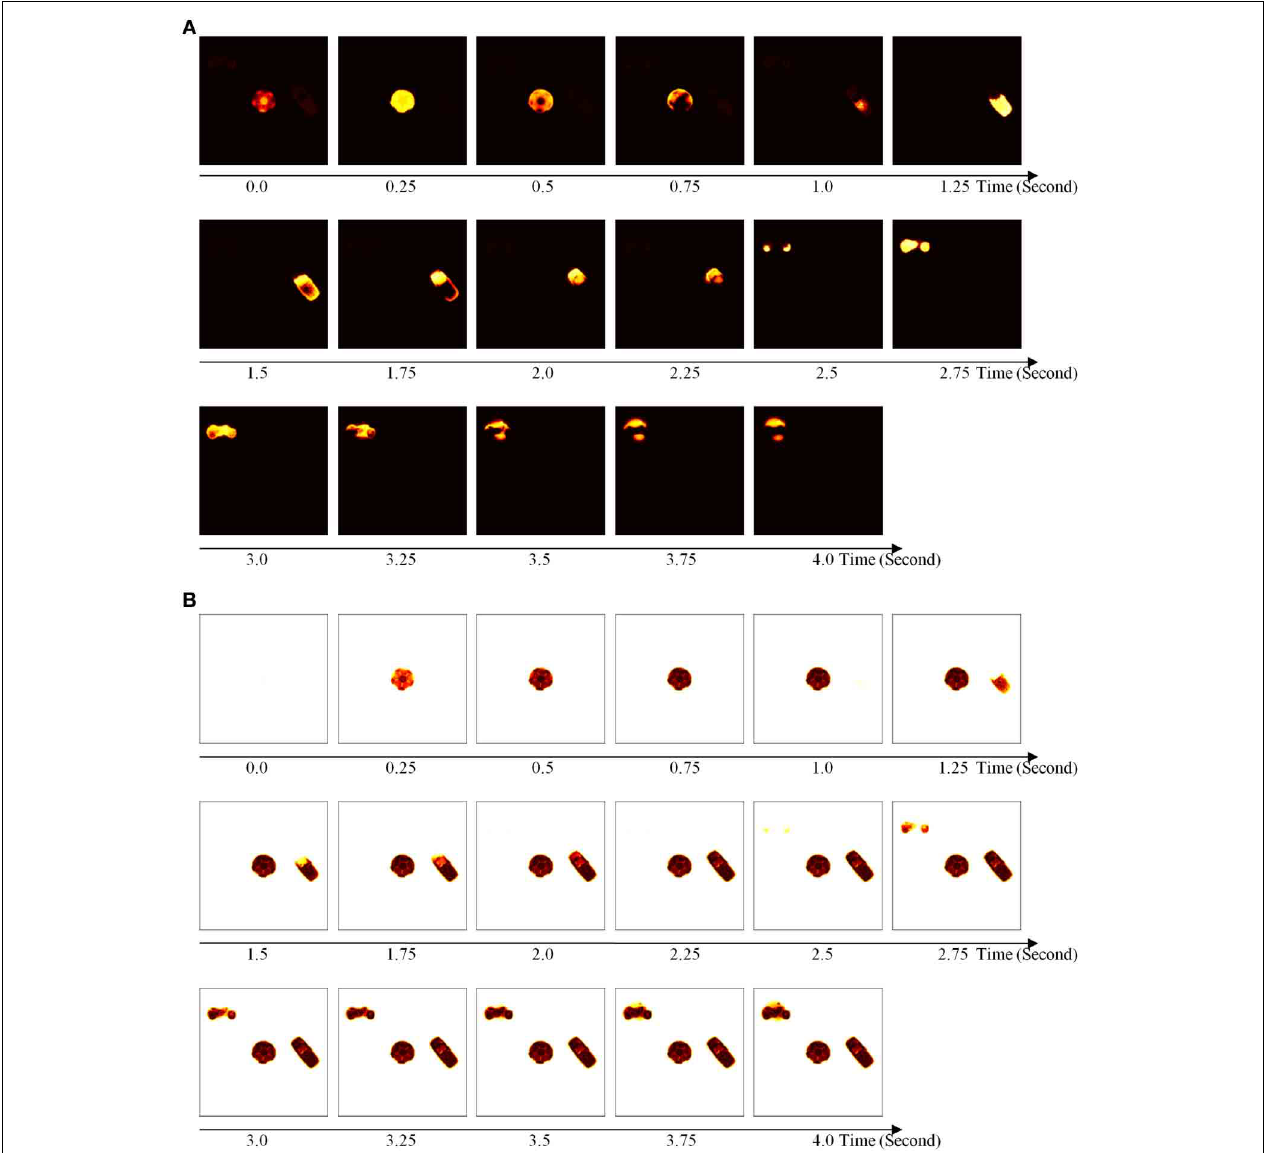
FIGURE 9 | Temporal dynamics of model simulations in spatial attention map and corresponding habituative transmitter representation. The input to the simulation contains three objects: a soccer ball, a cellphone, and a motorcycle (see Figure 8B ). Each slice represents neural activity at each time step. Darker colors represent